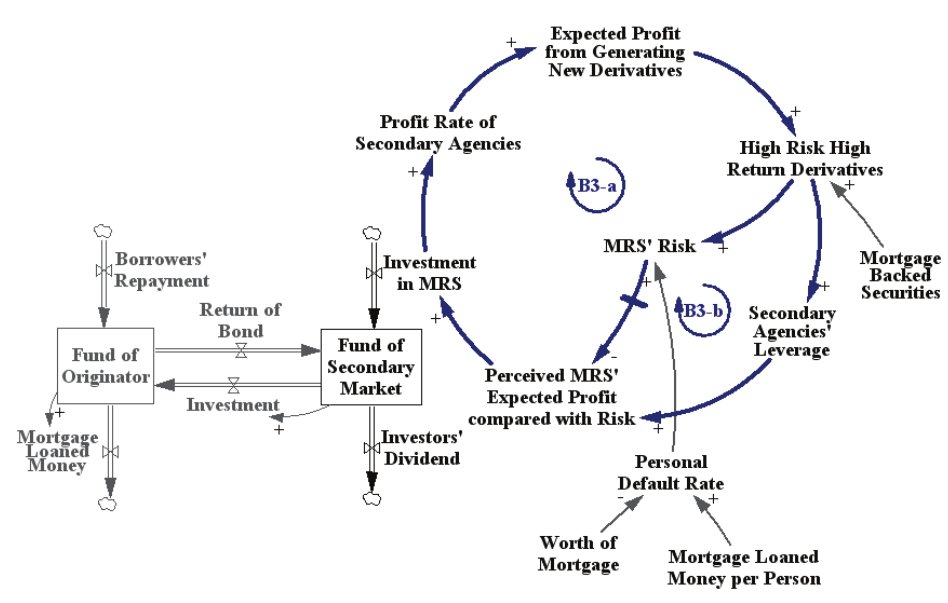
figure 8. adjustment of derivatives generation by mortgage